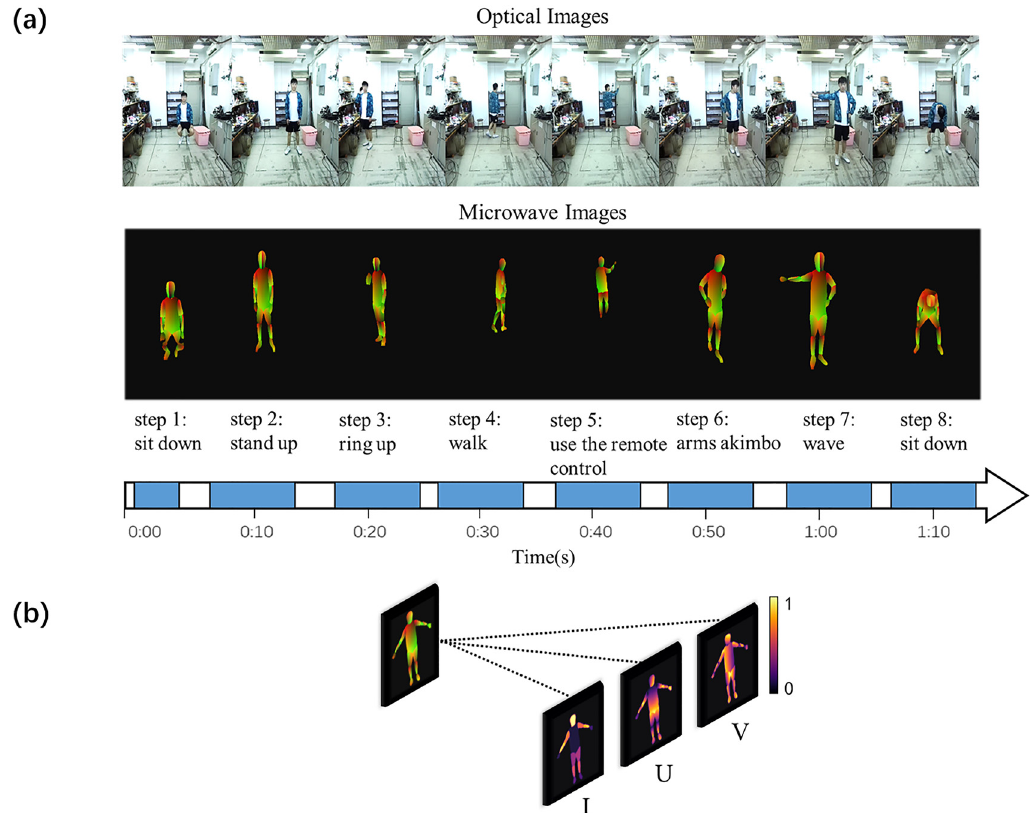
Figure 4: Experimental imaging results in indoor environment and the description of IUV image composition. (a)Experimental in-situ imagingresultsofthetestpersonfreelyactinginindoorenvironmentshowninFigure1d.( Top )TheopticalRGBimages atselectedmoments,whicharerecordedbyopticalZED2camera.( Middle )TheIUVimagesrecordedbyourintelligentEMmetasurfacecamera at selected moments corresponding to those in top row. ( Bottom ) Time line. (b) An IUV image has three channels: I-channel, U-channel, and V-channel. The I-channel image is the classi fi cation of pixels that belong to either background or different parts of body, which provide a coarse estimate of surface coordinates. The UV channels provide the result of mapping all human pixels of an RGB image to the 3D surface of the human